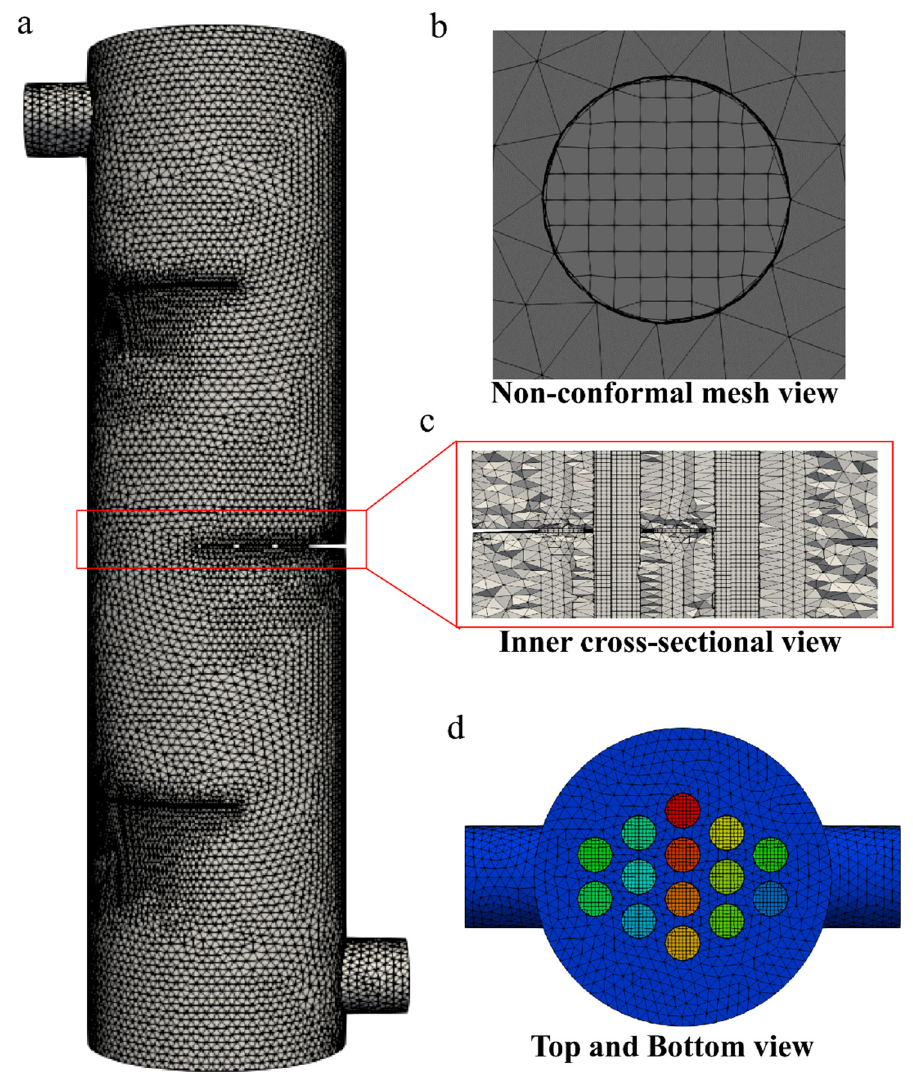
Figure 2. Generated multi-tubular reactor mesh for the CFD simulation. ( a ) External view of the reactor; ( b ) Non-conformal mesh view; ( c ) Detailed cross-sectional view; ( d ) Bottom and top view showing the 14 tubes.